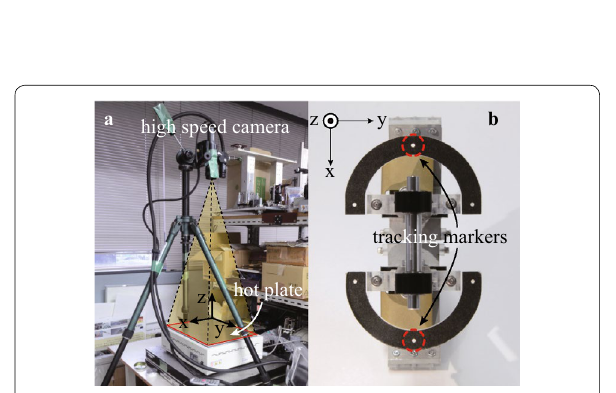
Fig. 14 Experimental setup and the view from the camera. The markers on the prototype were traced for gait observation